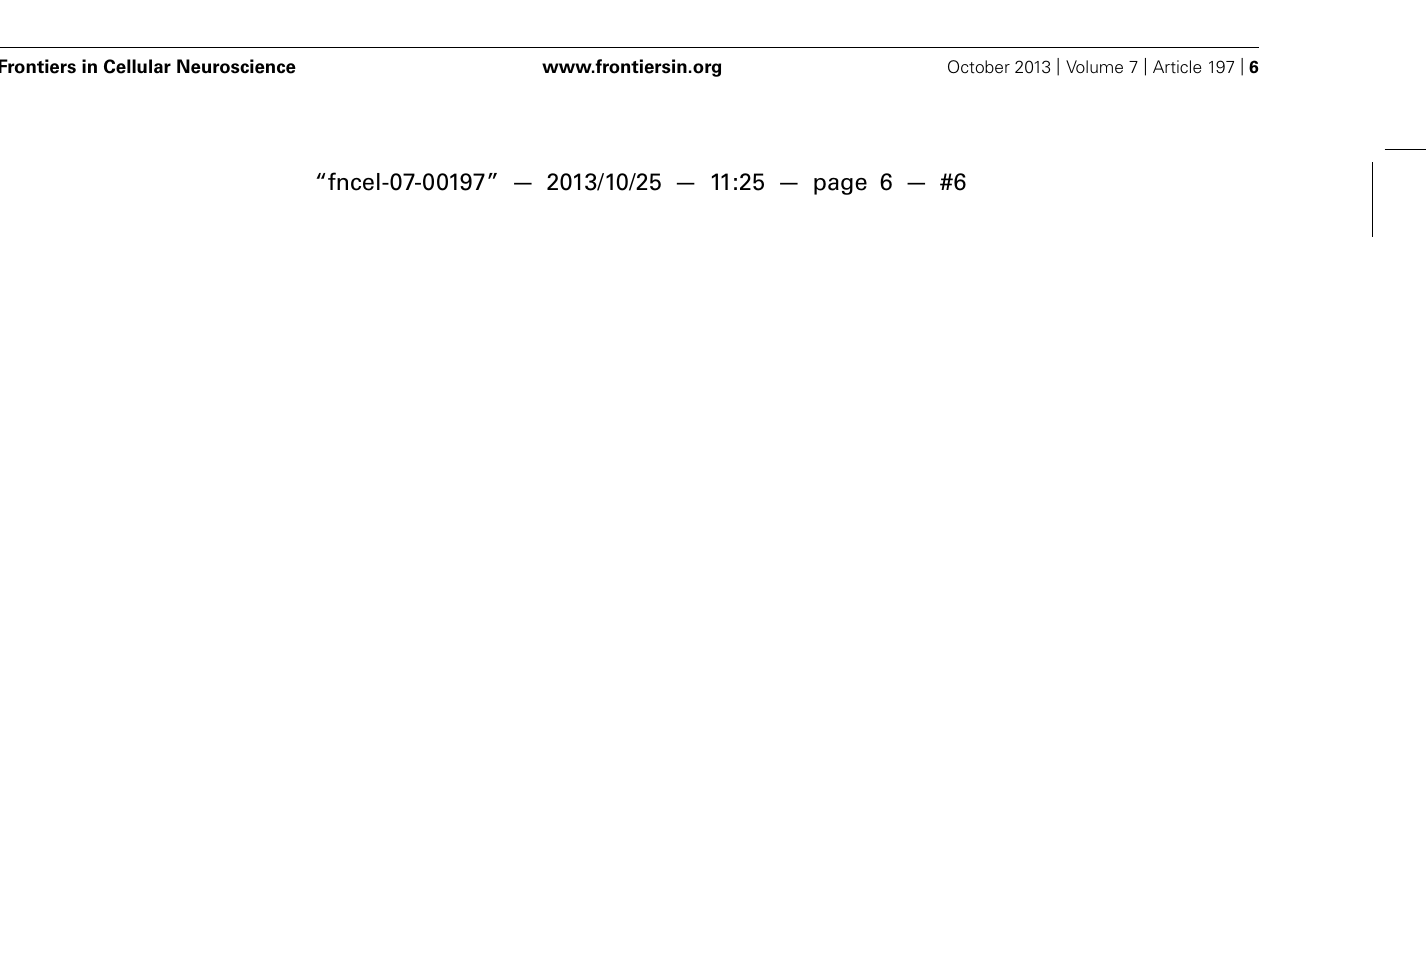
FIGURE 2 | Modulation of axon growth by purinergic receptors. (A) Schematic representation of the coordination of purinergic receptors and purines during the modulation of axon elongation in hippocampal neurons. Both ADP acting on P2Y1 and P2Y13 receptors, and ATP acting through P2X7 receptors, modulate adenylyl cyclase type 5 activity (AC5) in a coordinated manner.This coordinated signaling through AC5 serves to modulate cAMP intracellular concentrations and the activity of the PI3K-Akt-GSK3 α / β signaling pathway, the latter controlling axon elongation in hippocampal neurons